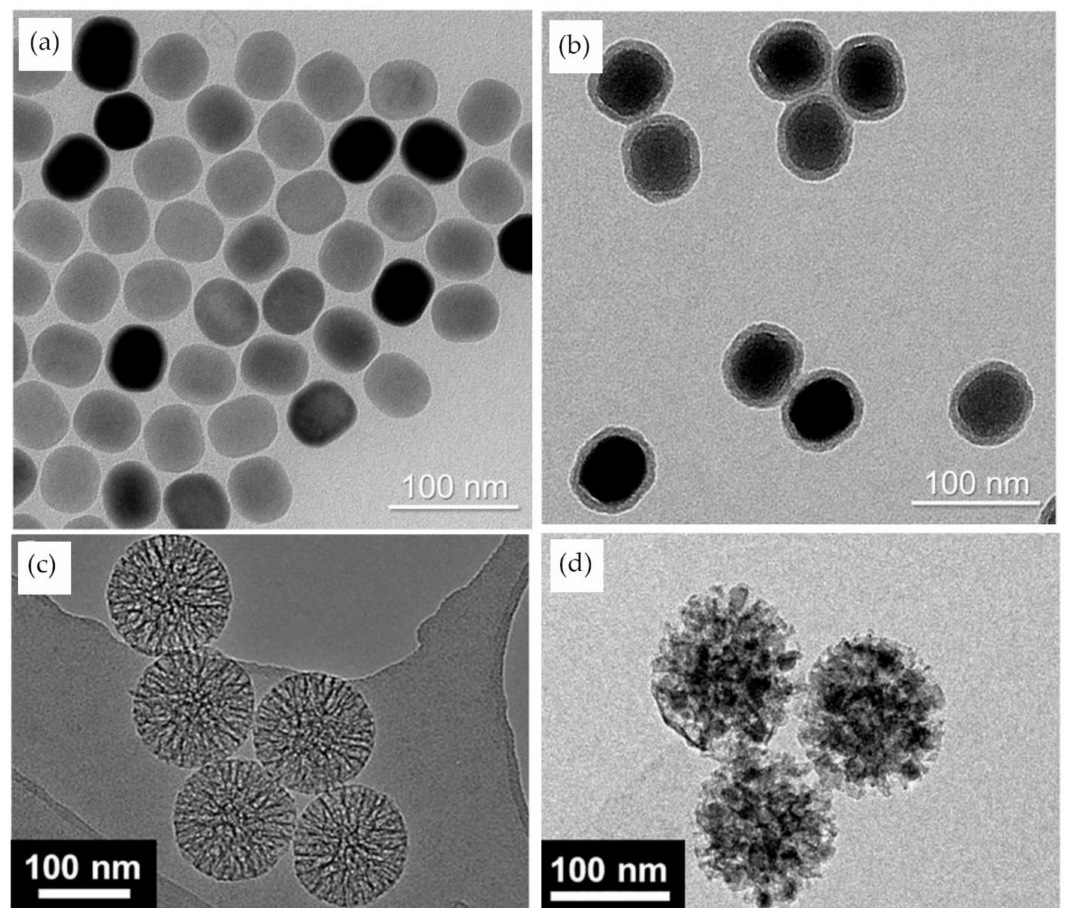
Figure 7. Combination of UCNPs with a silica core or shell: ( a ) TEM image of oleic acid-capped UCNPs; ( b ) TEM image of UCNPs with carboxylated silica shell; ( c ) SEM of mesoporous silica nanoparticles; ( d ) TEM image of CaF 2 : RE 3+ UCNPs embedded mesoporous silica nanoparticles. (Reproduced with permission from [53], published by American Chemical Society 2017; reproduced with permission from [55], published by Elsevier